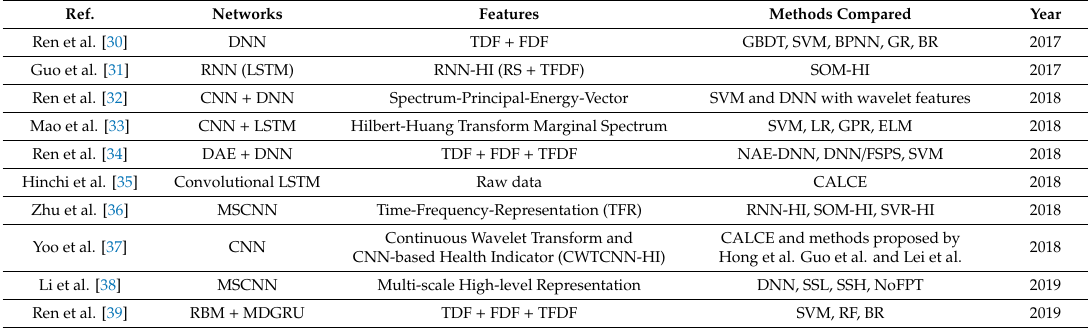
Table 1. Characteristics of deep learning methods for RUL prediction of bearings.